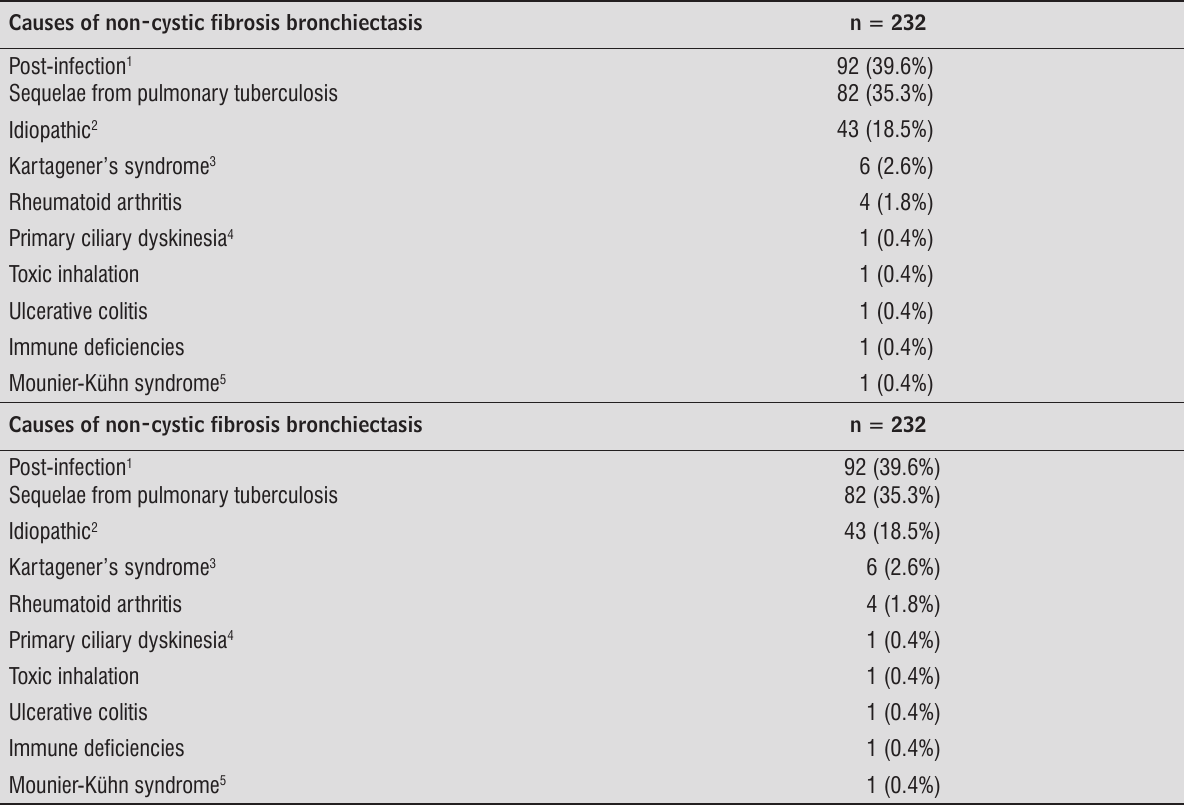
Table 2 – Causes of non-cystic fibrosis bronchiectasis (n =